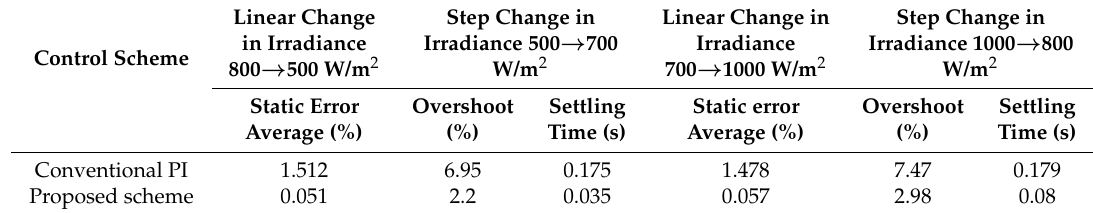
Figure 16. Grid currents and their zoom waveforms: ( a ) conventional control scheme; ( b ) proposed control schemes; under irradiation changes.